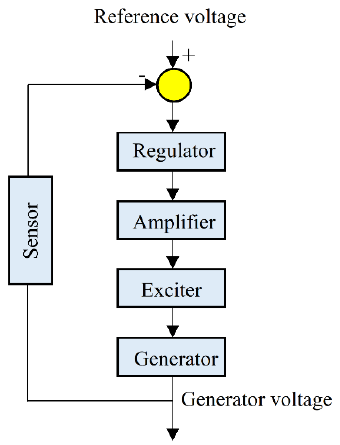
Figure 1. Block diagram of the AVR system.